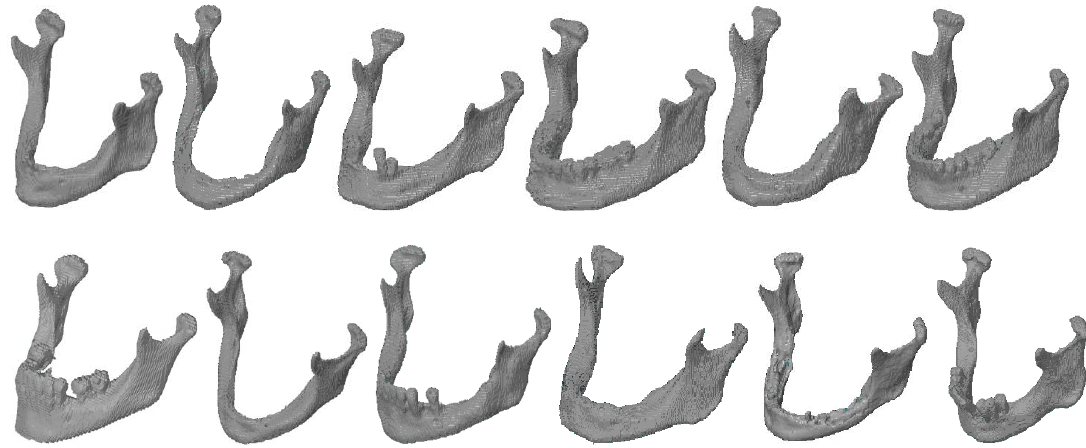
Figure 1. The anatomical structures of the mandible.